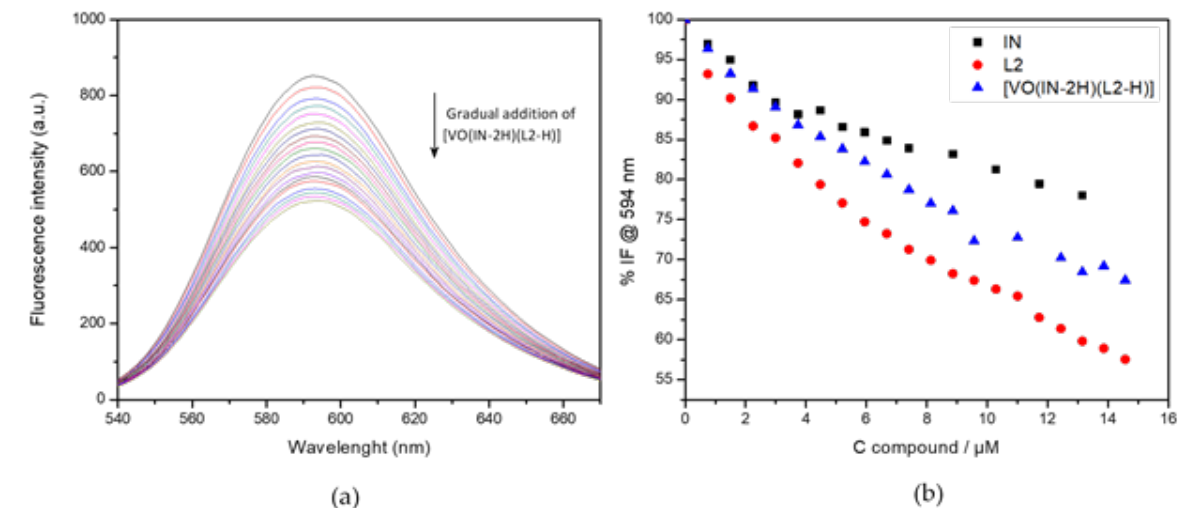
Figure 8. ( a ) Fluorescence quenching spectra ( λ exc = 510 nm) for {DNA–EB} adduct with increasing amounts of [V V O(IN-2H)(L2-H)]. ( b ) Relative fluorescence intensity (%) at λ = 594 nm with increasing compound concentration (C DNA = 1.5 mM, C EB = 0.75 mM, samples prepared in DMSO/buffer Tris HCl medium). Table 3. Stern–Volmer constants for [V V O(IN-2H)(L2-H)], L2 and IN for the competitive binding to {DNA-EB} adduct.